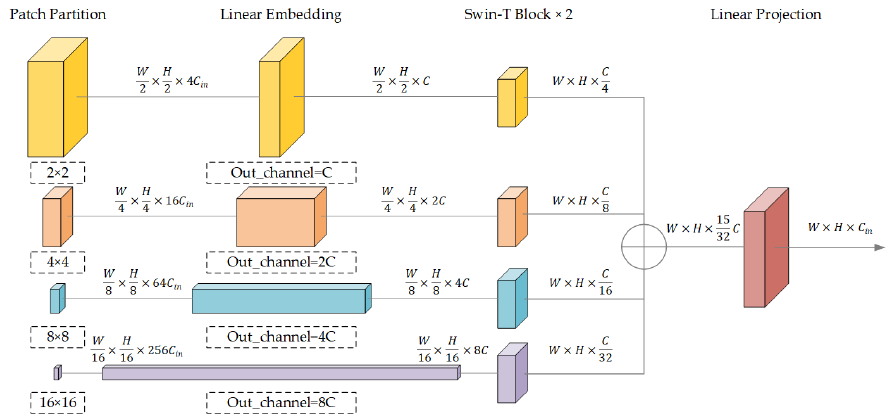
Figure 3. The schematic diagram of Swin-based Pyramid Pooling Module